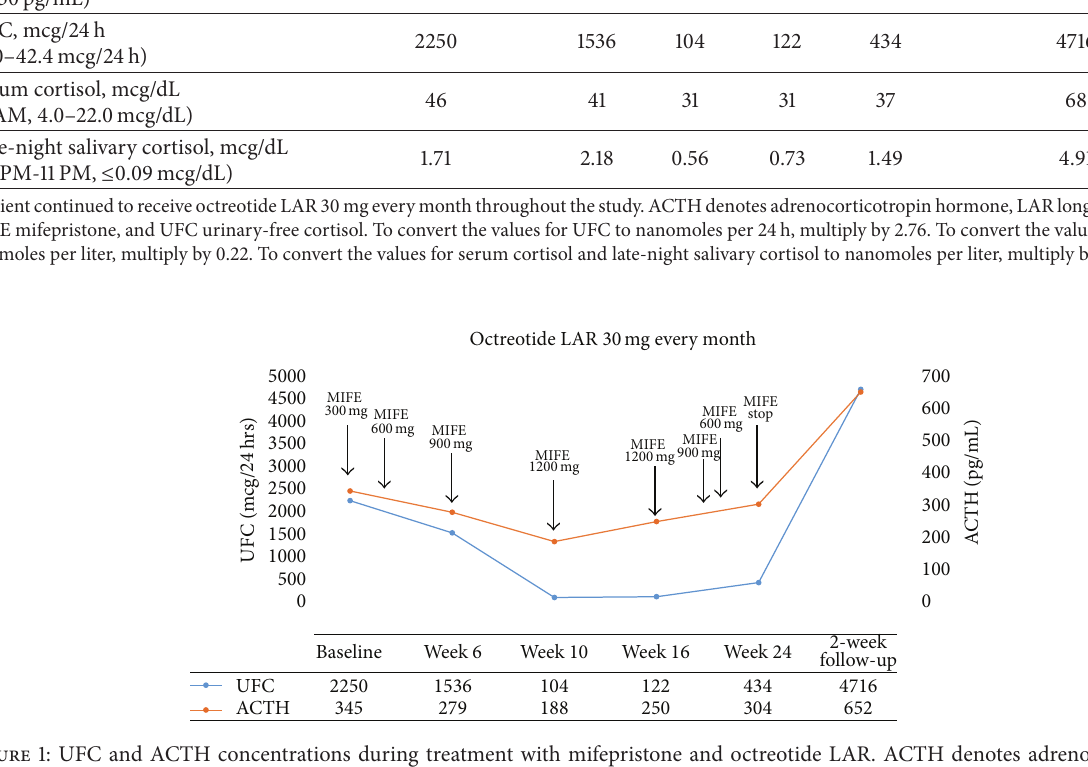
Figure 1: UFC and ACTH concentrations during treatment with mifepristone and octreotide LAR. ACTH denotes adrenocorticotropin hormone, LAR long-acting release, MIFE mifepristone, and UFC urinary-free cortisol. To convert the values for UFC to nanomoles per 24 h, multiply by 2.76. To convert the values for ACTH to picomoles per liter, multiply by